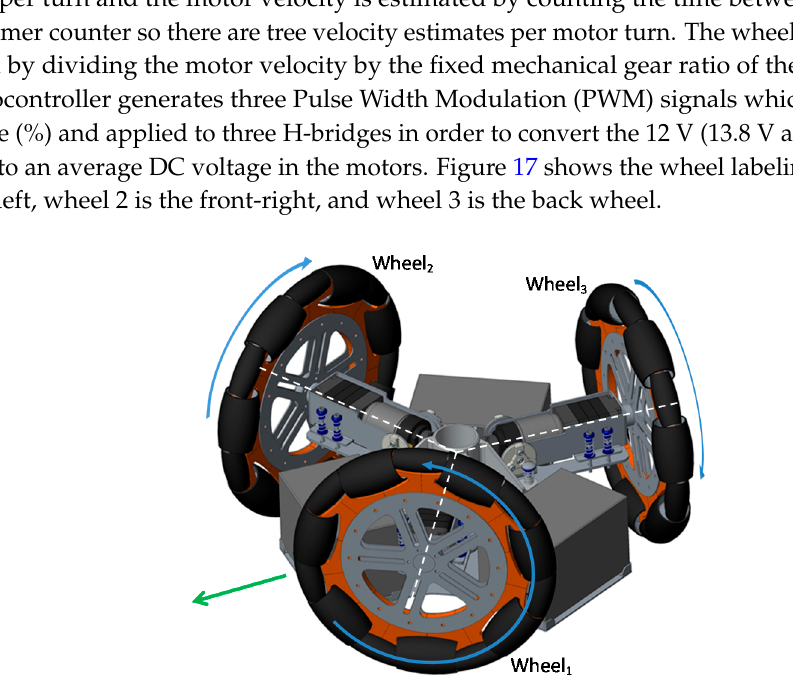
Figure 17. Detail of the labeling and positive angular velocity of the wheels. The green arrow depicts the front of the mobile